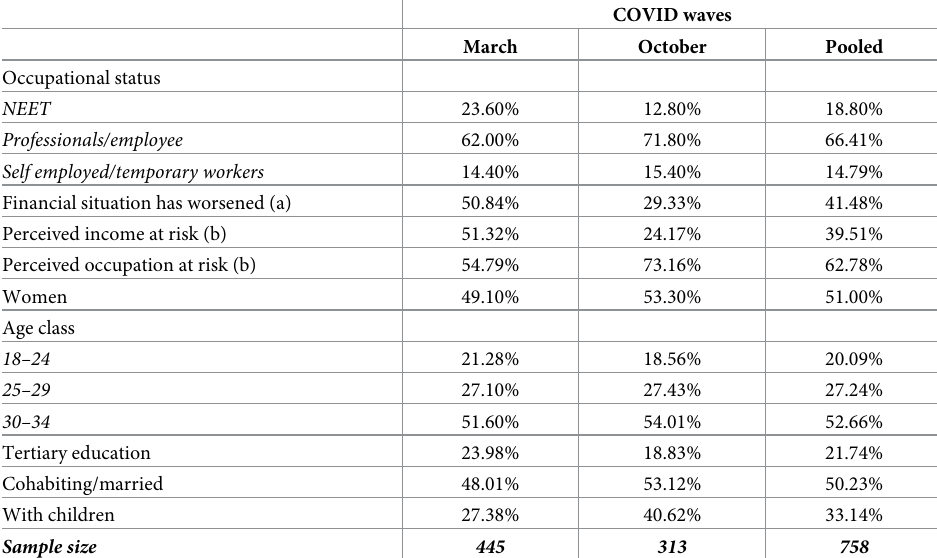
Table 4. Distribution of the main covariates and control variables for the COVID waves (March and October 2020); separated and pooled